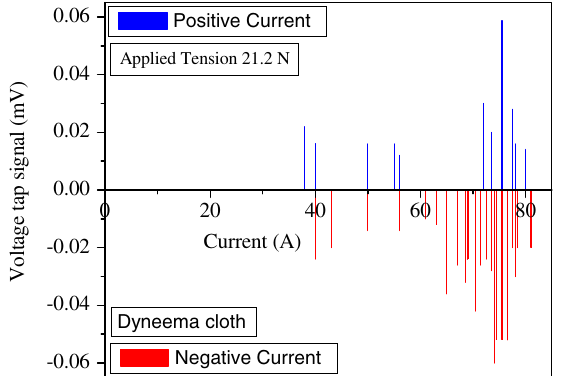
FIG. 6. (Color) Comparison of voltage tap signal after reversing the current polarity.